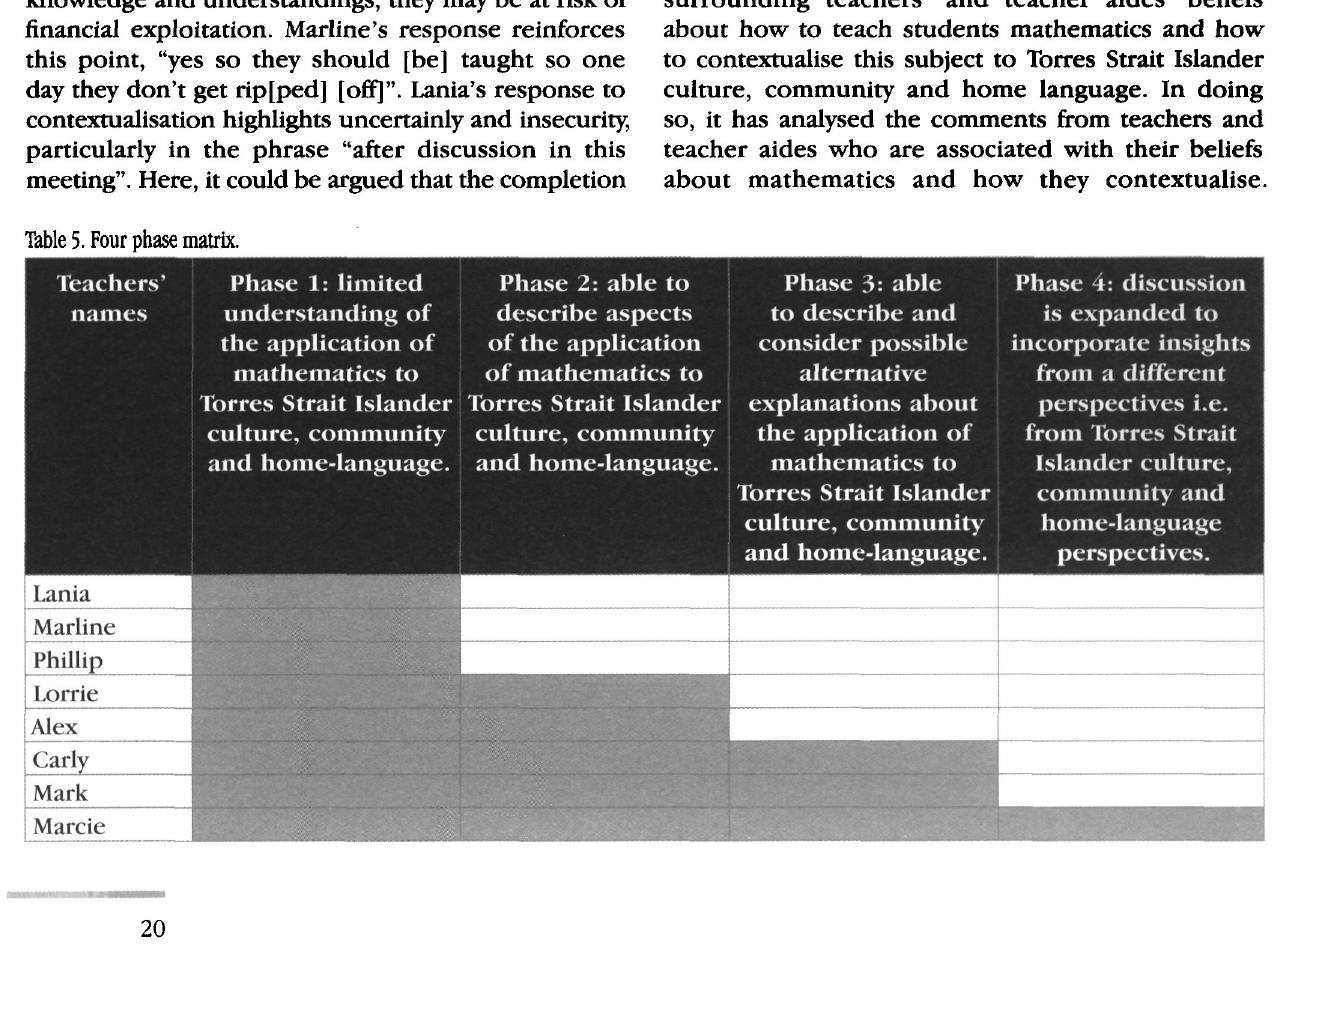
Table 5. Four phase